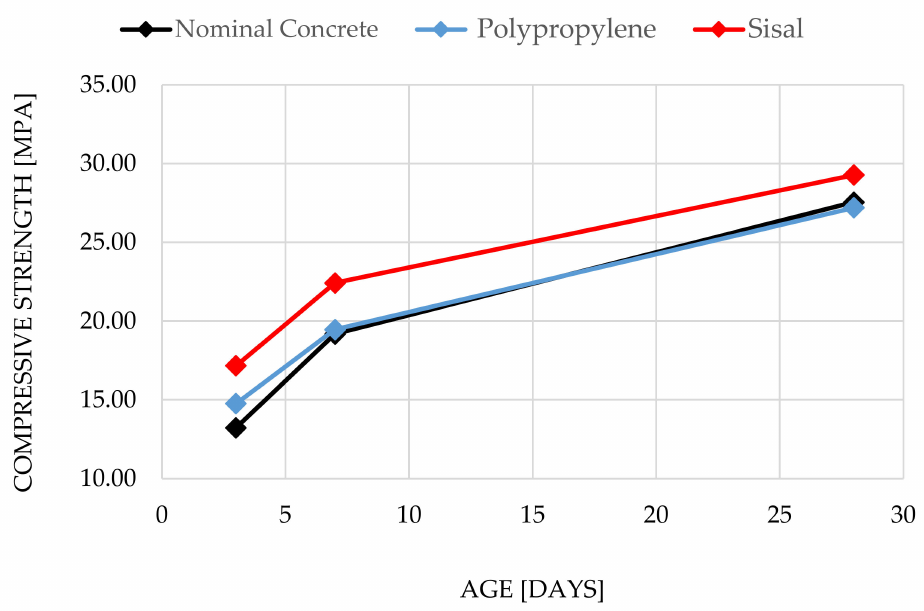
Figure 4. Compressive Strength ant the ages of 3, 7 and 28 days (1 kg/cm 2 = 0.0980665